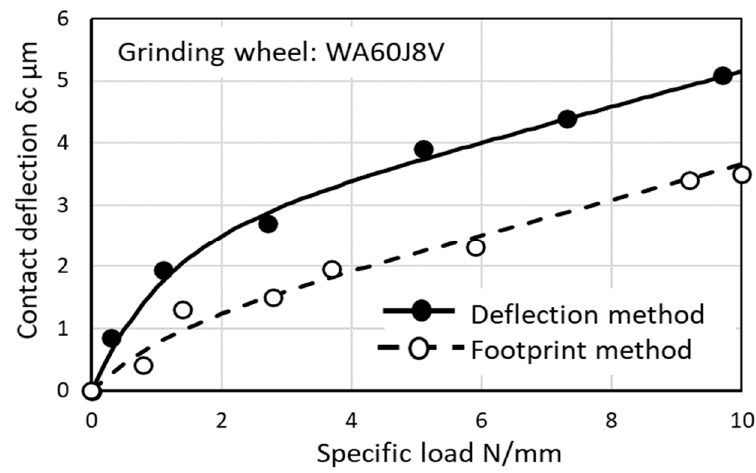
Figure13. Comparisonofwheeldeflectionsobtainedbythedeflectionmethodandthefootprintmethod. Figure 13. Comparison of wheel deflections obtained by the deflection method and the footprint method.